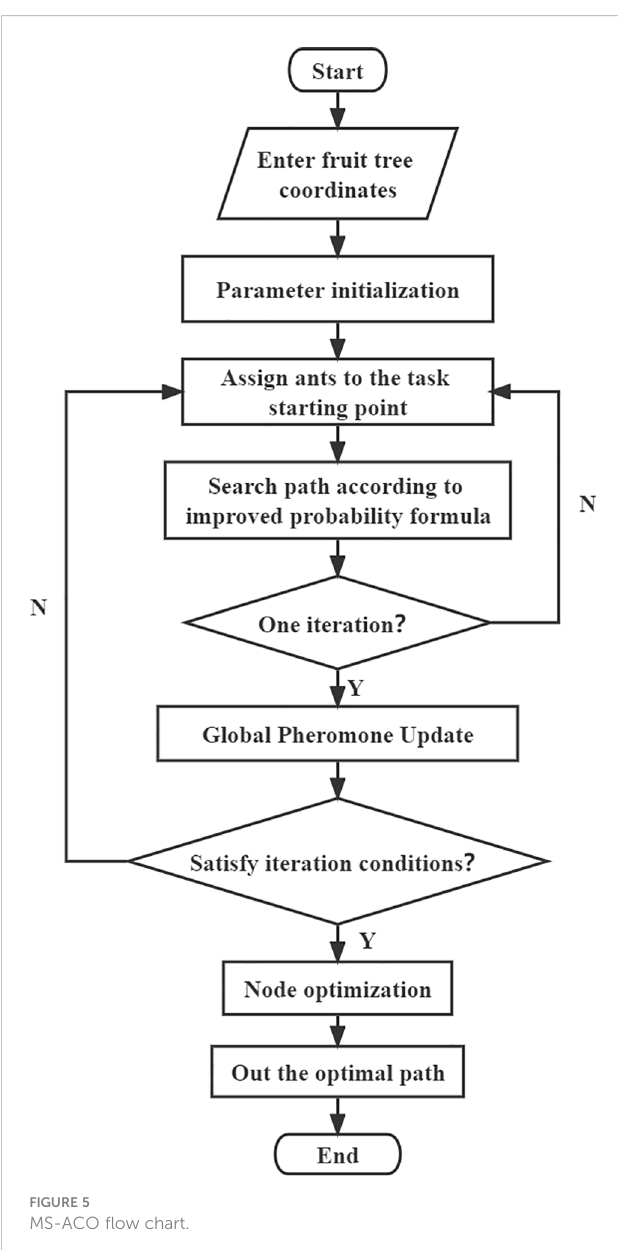
FIGURE 5 MS-ACO fl ow